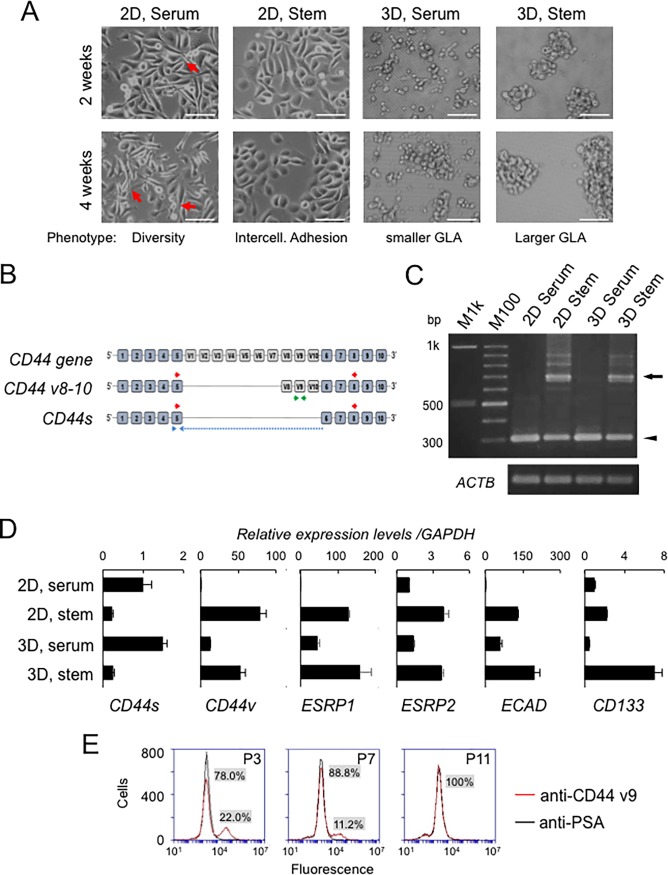
Gene expression switching of Epithelial-Splicing Regulatory Proteins (ESRPs), CD44 variant, and stem cell markers depending on cell culture nanoEnvironments.(A) Representative morphologies of PC-3 cells cultured in the 4 different conditions. Cells were cultured in 10% serum-containing F12K medium or mTeSR1 stem-cell medium on 2D plates or 3D NCPs. Arrows indicate projections of cells. Scale bars, 100 μm. (B) Schematic structures of CD44 gene, CD44 variant 8–10 (CD44v8-10) and CD44 standard (CD44s). Blue and gray rectangles represent standard exons (exon 1 to 10) and variant exons (V1 to V10), respectively. The red primer pair is for all variants and the CD44s. The green primer pair is for CD44v containing exon V9. The blue primer pair is for CD44s only. (C) Agarose gel electrophoresis analysis of RT-PCR amplicons of CD44v and CD44s. An arrow indicates CD44v8-10 amplicon. An arrowhead indicates CD44s amplicon. M1k, a 1 kbp DNA ladder marker. M100, a 100 bp DNA ladder marker. ACTB, β-actin mRNA as an internal control. (D) qRT-PCR analysis of stem-cell-related and epithelial-splicing regulatory genes. The mRNA expression levels of CD44s, CD44v, ECAD/CDH1, ESRP1, ESRP2, and CD133 were examined. Relative mRNA expression levels versus those of GAPDH are shown. n = 3. (E) Flow cytometry analysis of CD44v9. PC-3 cells were cultured in serum-containing medium and passage number 1, 7, and 13 were examined by flow cytometry. An anti-prostate-specific antigen (PSA) antibody was used as a negative control. Serum promoted differentiation of the cells and reduced stemness.